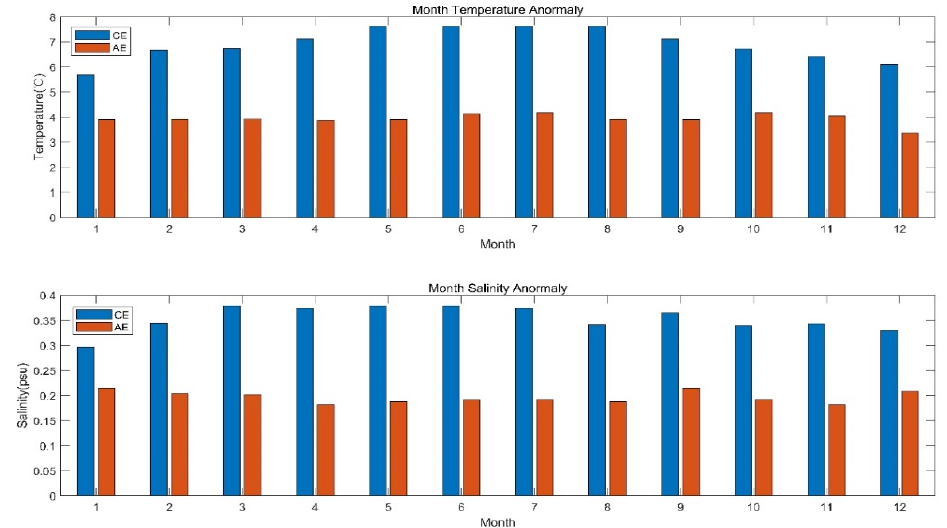
Figure 16. ARMOR 3D composite temperature and salinity anomalies in different months.